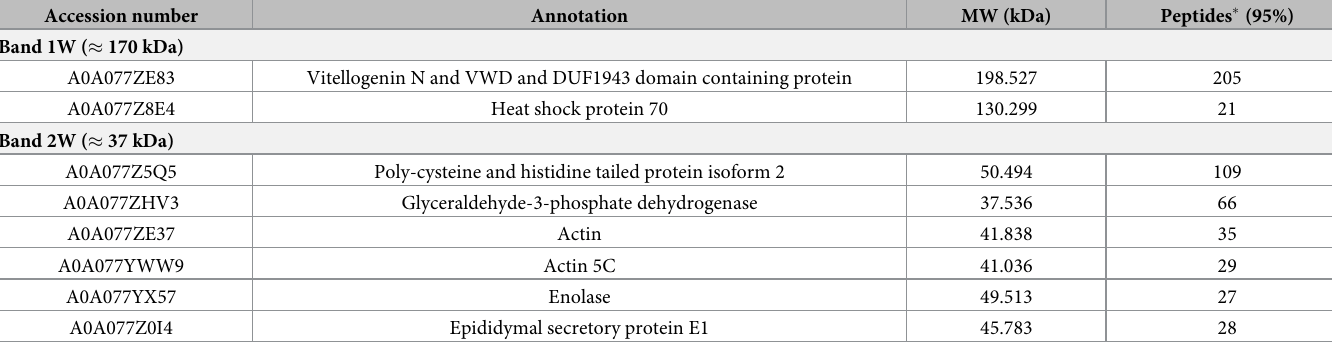
Table 2. Potential identity of the EE proteins targeted by serum antibodies based on the MW data of the EE proteome. Accession